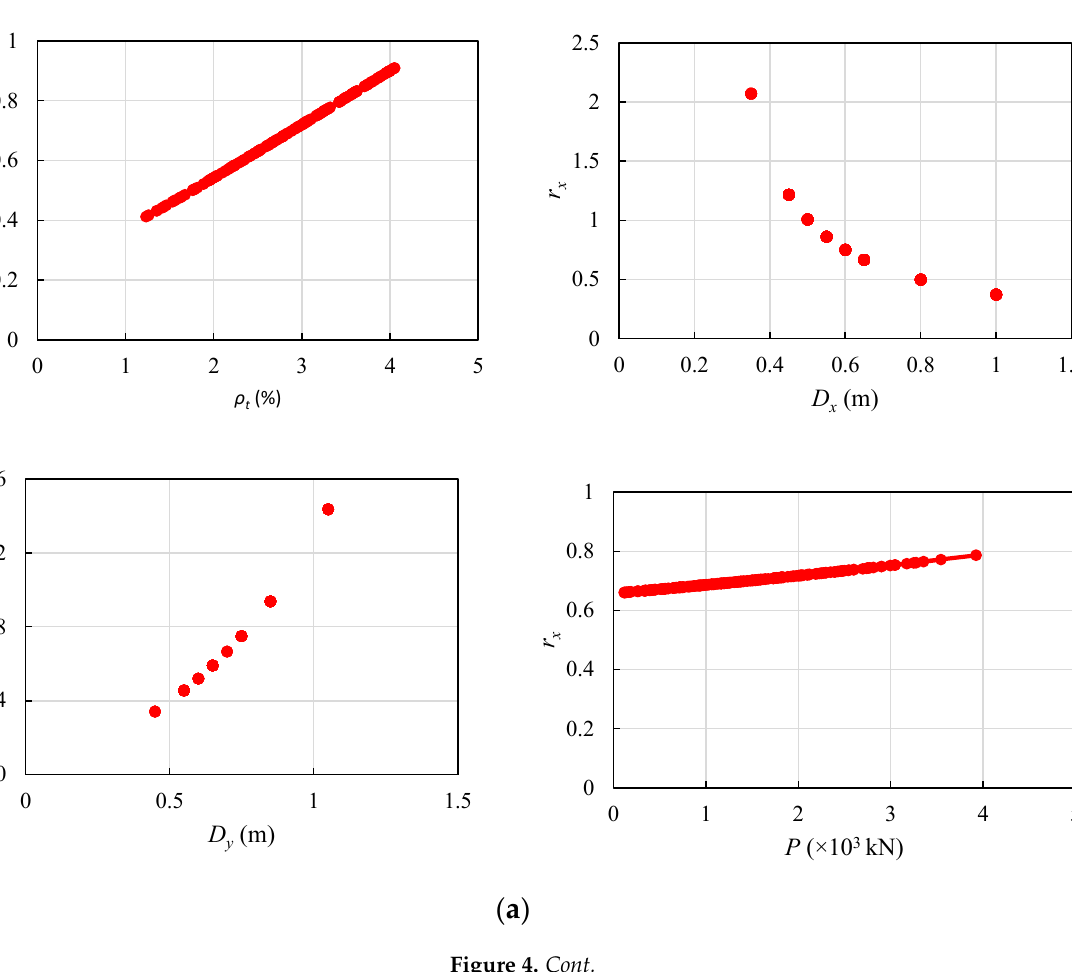
( b ) Figure 4. Effective stiffness ratio of RC column sections parametric analysis in the GEP ‐ based model; ( a ) r x ( b ) r y . As presented in Figure 4, r x continuously increases with increasing ρ t , P , and D y , which agrees with the trend reported by Kuntia and Ghosh [12] Similarly, r y increases